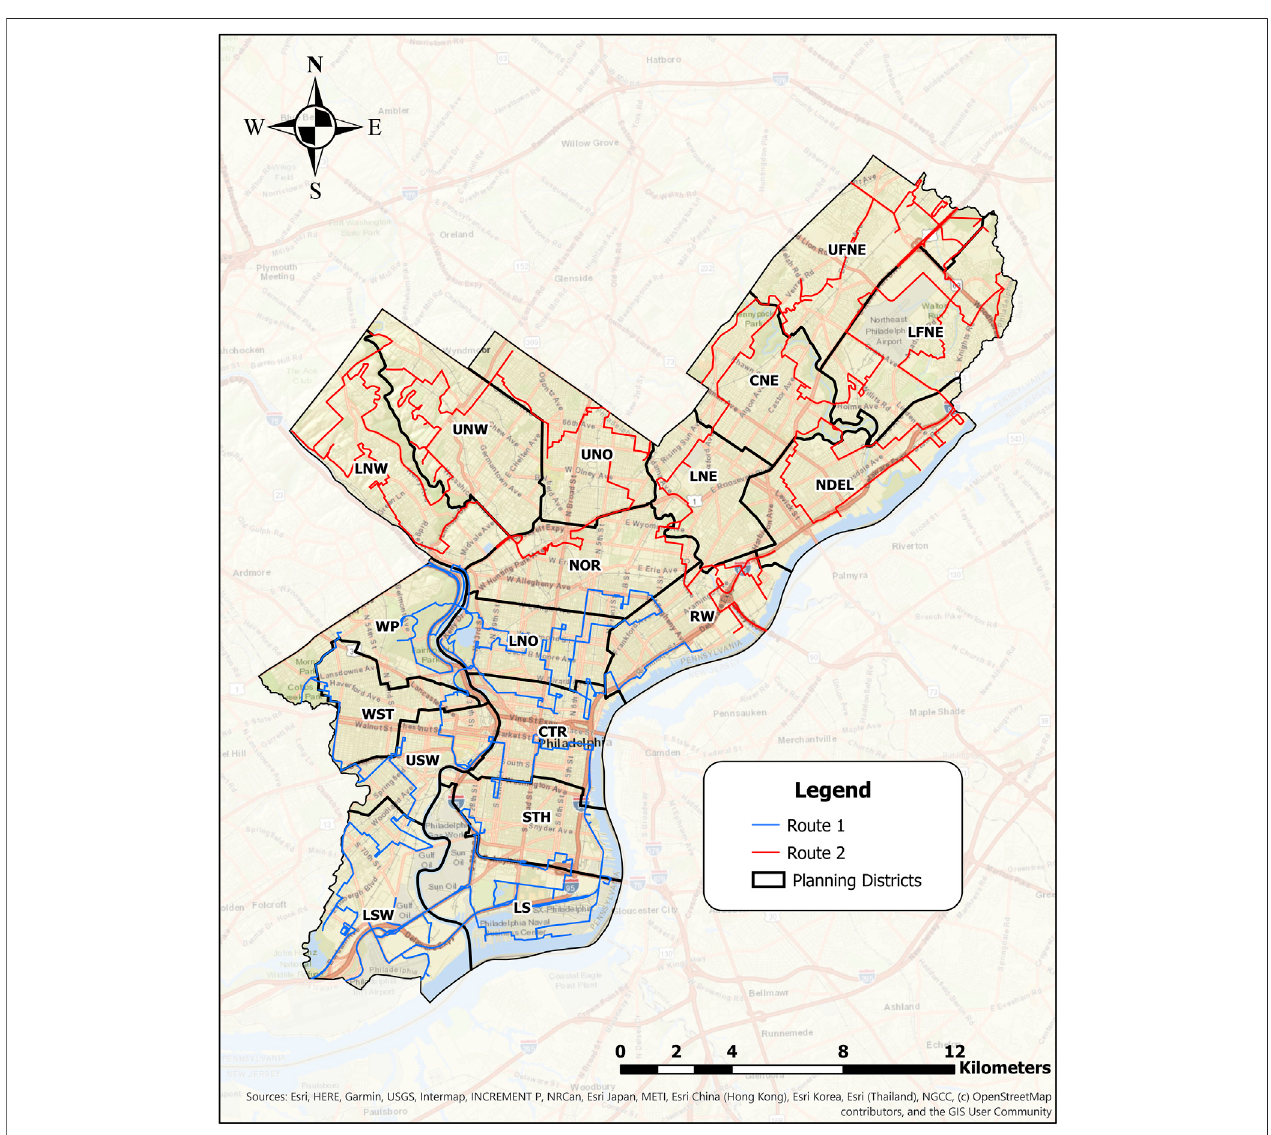
FIGURE 1 | Map of study area, including routes traveled for mobile air pollution monitoring and Philadelphia planning districts. Abbreviations on the map denote each planning district in Philadelphia.